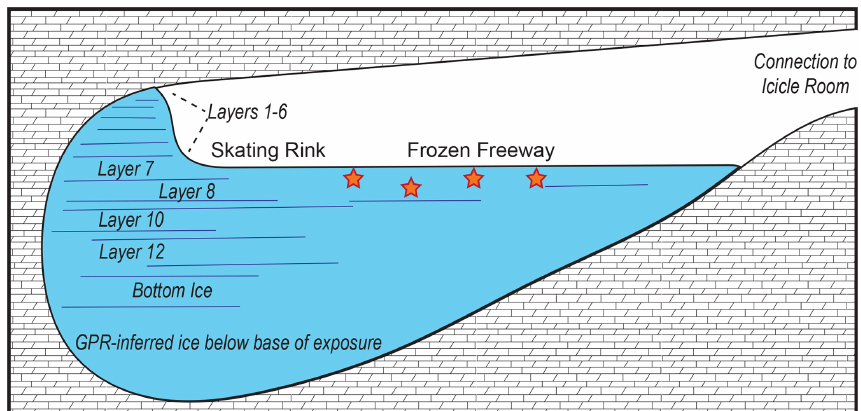
Figure 2. Schematic illustrating the relationship between the Frozen Freeway, where most 14 C samples were collected from shallow depths within the ice, and the taller exposure at the Skating Rink, where most samples for stable isotopes and glaciochemistry were collected. This exposure reached to the cave ceiling, and the part projecting above the Frozen Freeway contained six visibly distinct layers. Intermediate parts of this exposure were also visibly layered, with Layers 7 and 8 corresponding stratigraphically to the near-surface layers of the Frozen Freeway, where the 14 C samples were collected. The bottom ice in this exposure did not appear to be layered, although it was difficult to view this ice directly. The total height of the Skating Rink exposure is